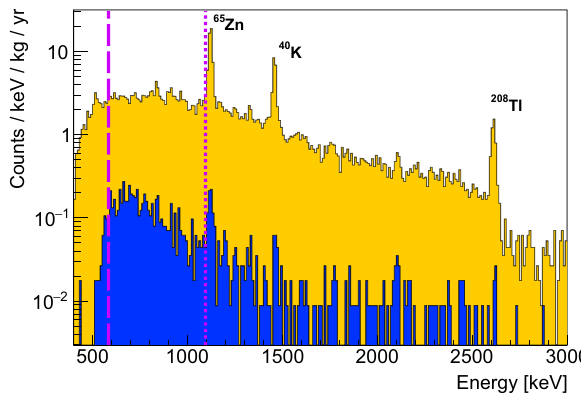
Fig. 3 Yellow: spectrum of the sum of the energies simultaneously released in two crystals. Blue: the same spectrum requiring that one of the two energies was equal to 511keV ± 2 σ . The vertical bars indi- cate the total energy of the Signatures D (dotted) and E (dashed). We highlight that Signature D is partly overlapped to the peak of 65 Zn